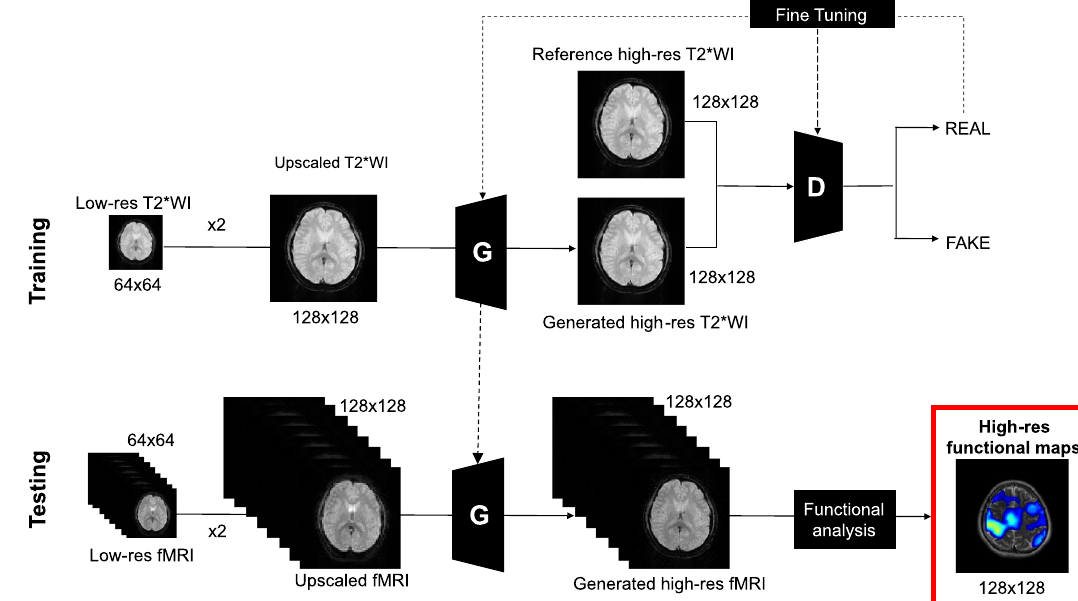
Figure 1. Overview of the Static T2*WI-based Subject-Specific Super Resolution fMRI (STSS-SRfMRI) scheme proposed in this study. The upper and lower parts correspond to the training and testing phases, respectively. In the training phase, the generator (G) was optimized to form a relationship between the low-resolution and high-resolution T2*WI. The discriminator (D) made a decision whether the input was “real” (i.e., the reference high-res T2*WI) or “fake” (i.e., the generated high-res T2*WI). G learned to generate more realistic output via feedback from D. In the testing phase, a high-resolution functional MRI (fMRI) time series was